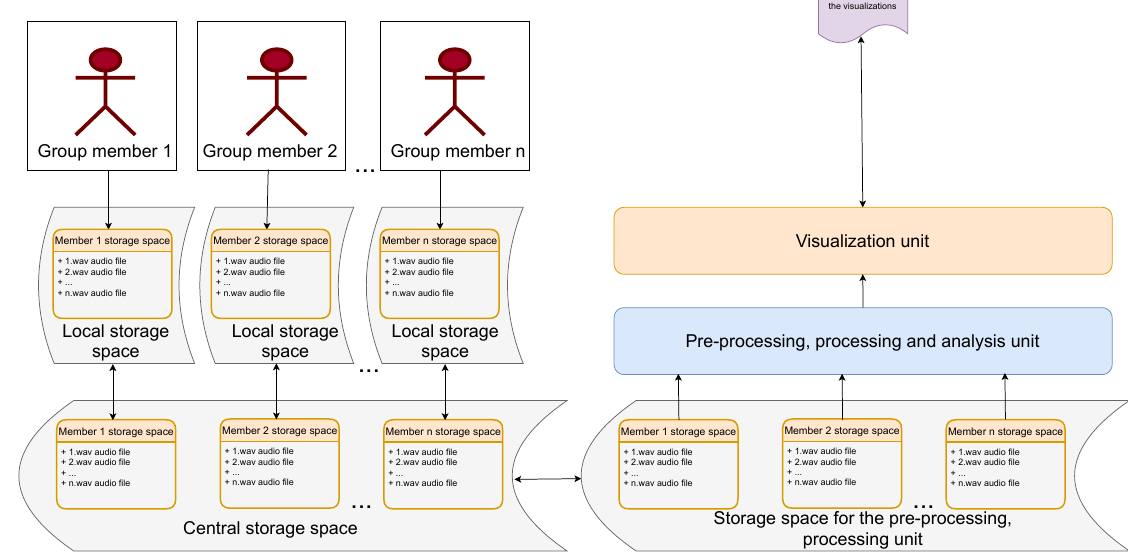
Figure 1. Architecture for collecting and analysing audio data during